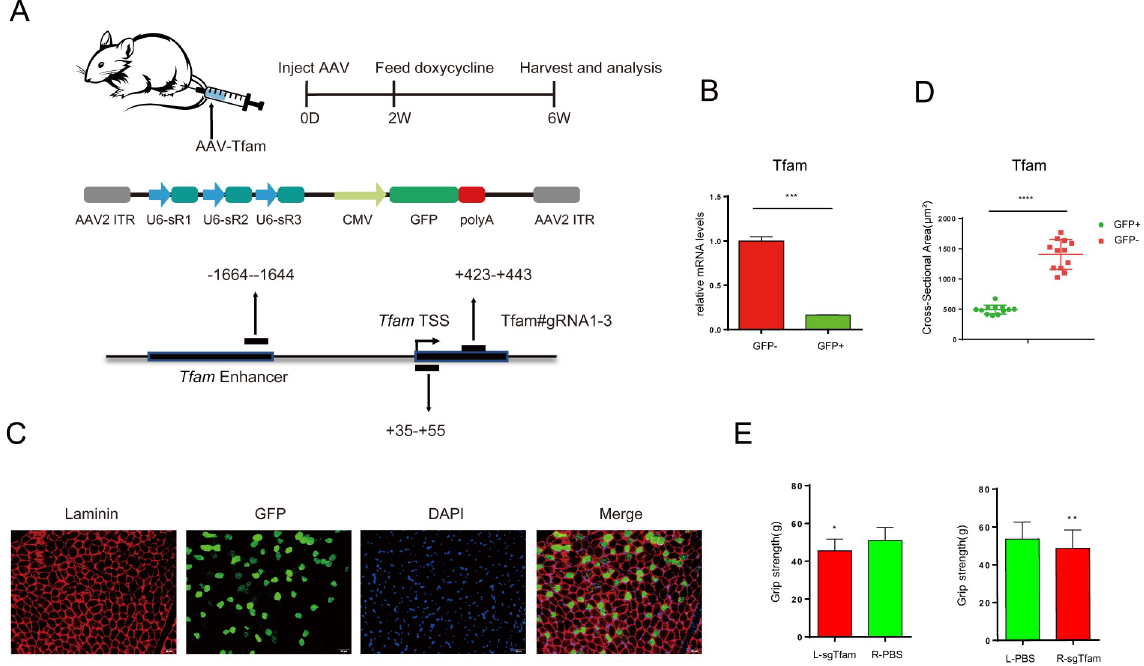
Fig 7. In vivo inducible CRISPRi effect of the iKRAB KI mouse. (A) Schematic diagram shows that AAV expressing multiplex gRNAs against Tfam locus was injected into the tibialis anterior muscle of the iKRAB KI mice, followed by 1 month of Dox induction and the subsequent analysis. (B) RT-qPCR analysis showing Tfam mRNA levels in the designated groups. (C) IF analysis of laminin expression of the tibialis anterior muscle tissue around the injection sites. GFPs mark the infected muscle fibers. The scale bar represents 50 μ m. (D, E) Quantification of the cross-sectional area of the tibialis anterior muscle fibers and grip strength in designated groups ( n = 6 mice). L, left; R, right. The data in B, D, and E are presented as means ± SD ( n = 3 or 6) ( � p < 0.05, �� p < 0.01, ��� p < 0.001, ���� p < 0.0001; and 2-tailed unpaired t test). The numerical values used to generate graphs in panel B, C, and E are available in S1 Data. AAV, adeno-associated viral; CRISPRi, CRISPR interference; GFP, green fluorescent protein; IF, immunofluorescence; KI, knock-in; RT-qPCR, reverse transcription PCR; SD, standard